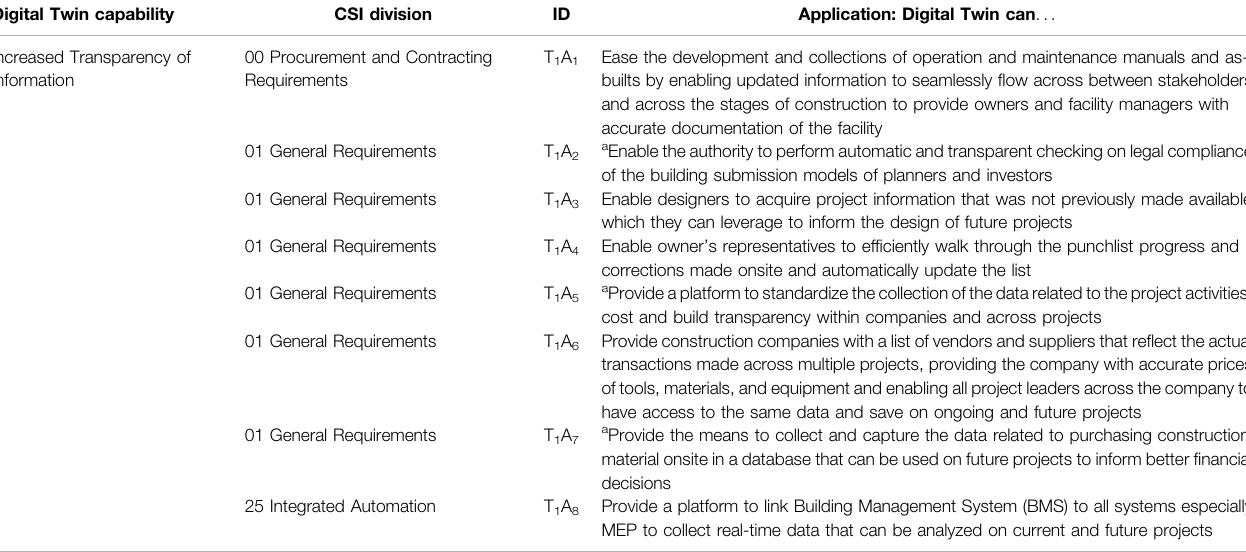
TABLE 3 | Digital Twin capability of Increased Transparency of Information and the identi fi ed applications. Digital Twin capability CSI division ID Application: Digital Twin can ...